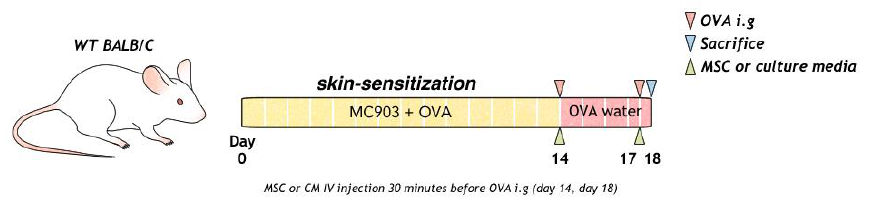
Figure 1. Process of allergic sensitization to food in mice with OVA, MSC, or MSC CM is